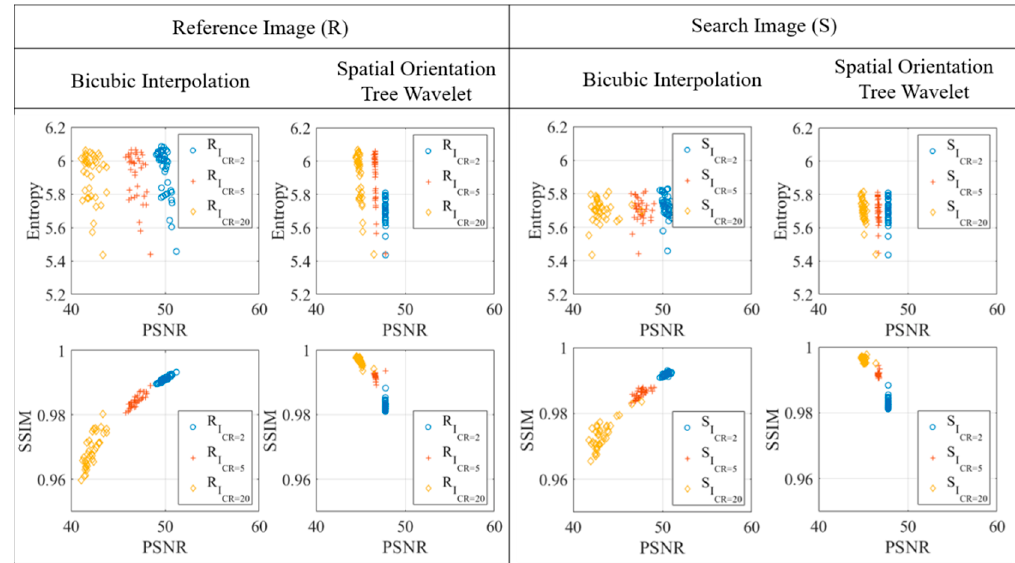
Figure 9. Evaluation of bicubic and STW compression quality of 76 images (38 each for reference and search images) used in the photogrammetry step.